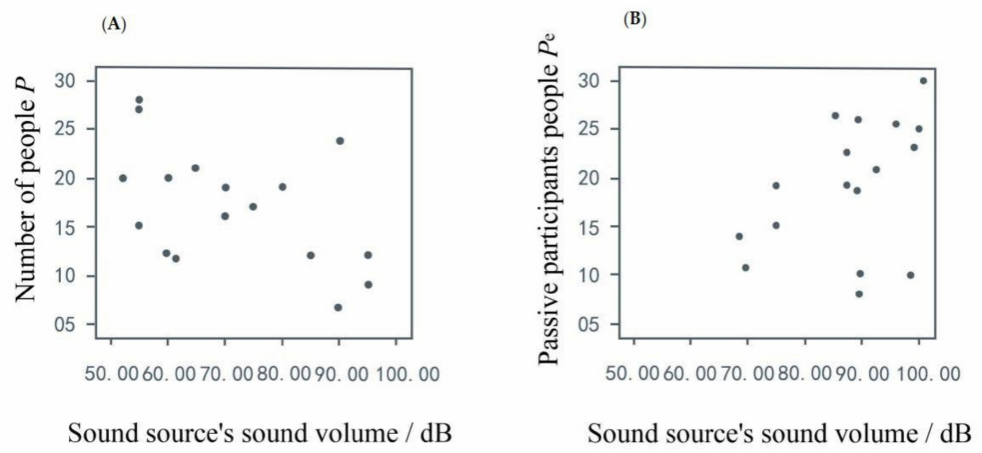
Figure 5. People and sound volume scatter diagram. ( A ) Sound volume has a negative relationship with the number of people. ( B ) Sound volume has a positive relationship with the number of